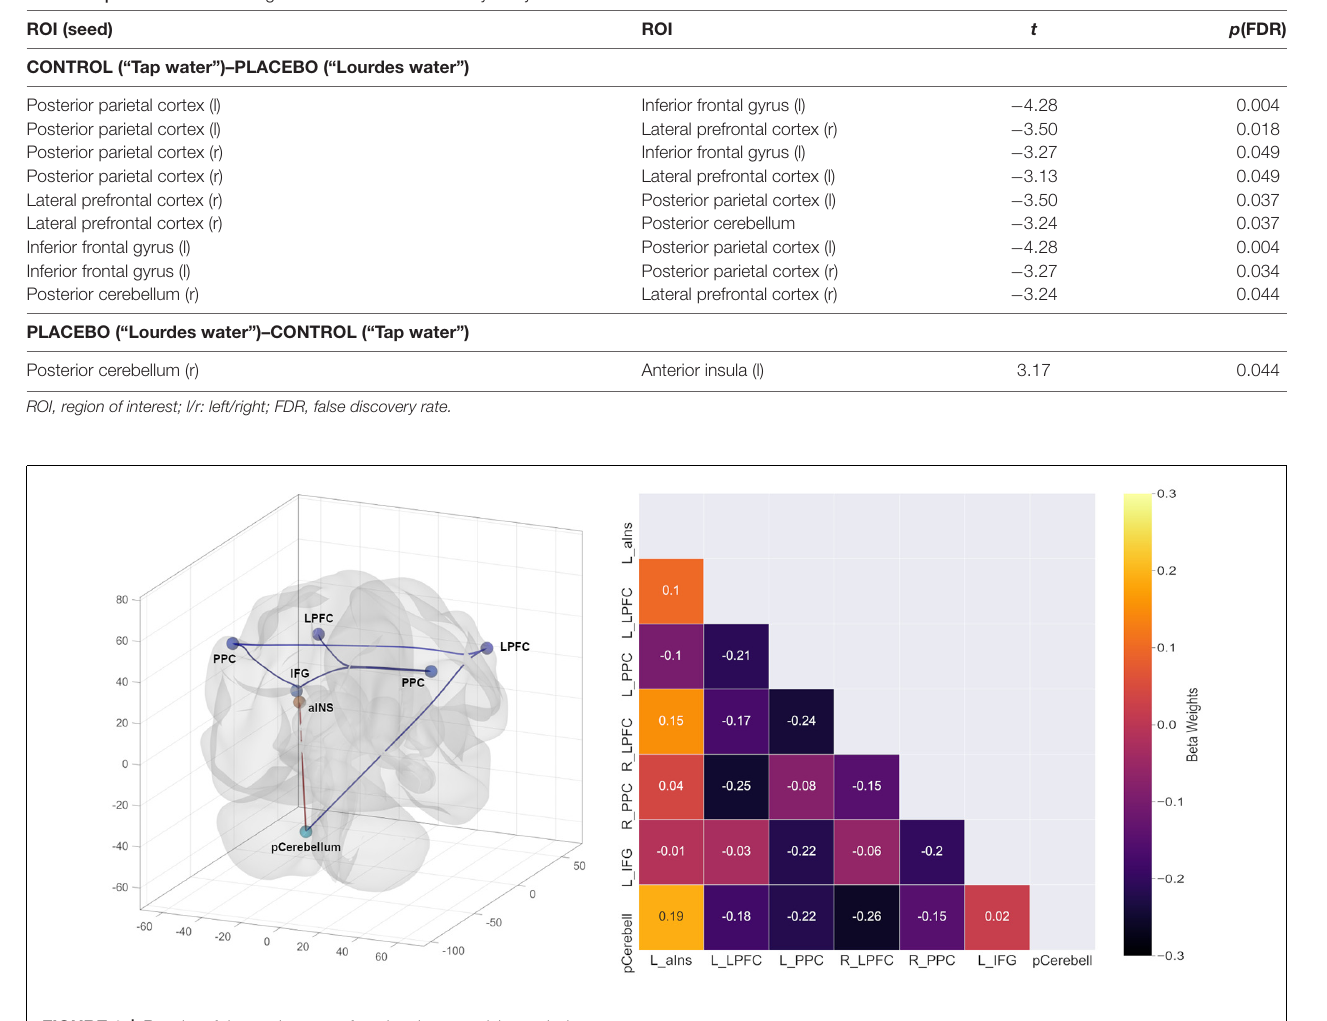
correlated rsFC with the difference scores for the ratings in the two conditions (PLACEBO minus CONTROL). Changes in bodily sensations were positively correlated with rsFC between occipital and inferior frontal regions, and negatively with rsFC between inferior frontal regions and temporal/parietal regions ( Table 3 ). Changes in the intensity of feelings were not correlated with